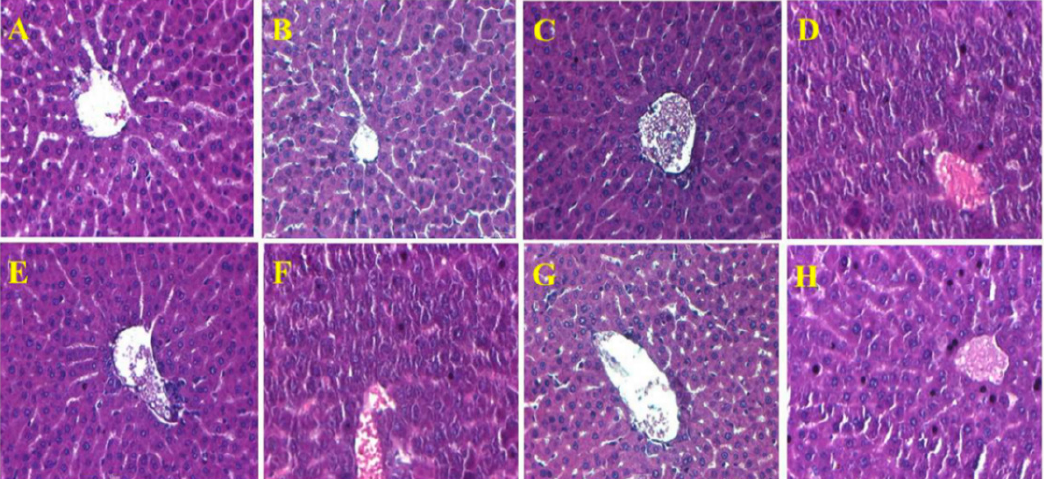
Figure 4. Hematoxylin and eosin-stained sections of rat livers (40×): ( A ) Normal control rat liver: Normal liver architecture; ( B ) Vehicle alone-treated rat liver: Normal liver architecture; ( C ) Biochanin A (40 mg/kg)—treated rat liver: Normal appearance of liver cells; ( D ) Arsenic (10 mg/kg)—treated rat liver: Blurred appearance, absence of intact nuclei and RBC congestion; ( E ) Arsenic + Selenium (3 mg/kg)—treated rat liver: Normal hepatocytes; ( F ) Arsenic + Biochanin A (10 mg/kg)—treated rat liver: Blurred appearance, absence of intact nuclei and congestion of RBC; ( G ) Arsenic + Biochanin A (20 mg/kg)—treated rat liver: Normal architecture of liver with disarrangement of radial pattern of hepatocytes; ( H ) Arsenic + Biochanin A (40 mg/kg)—treated rat liver: Disarrangement in radial pattern of hepatocytes and sinusoidal space.